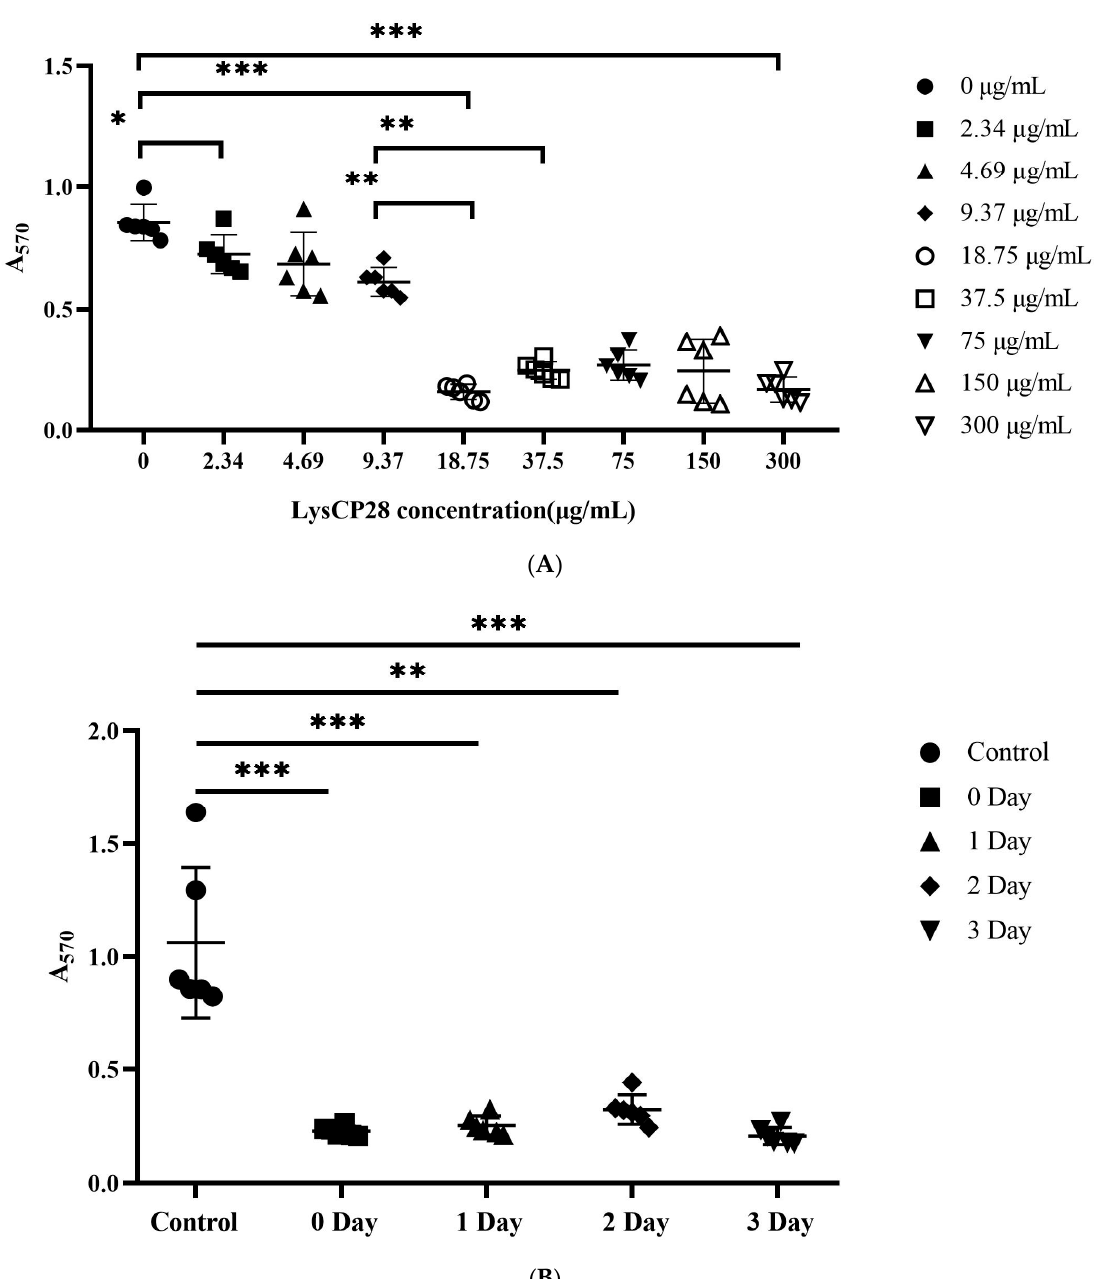
Figure 5. Efficacy of endolysin as antibiofilm agent against C. perfringens J21 strain. ( A ) Preformed biofilms (3-days-old) treated with different concentrations of LysCP28 over 24 h at 37 °C. ( B ) Inhibition in the biofilm formation (1-day-, 2-day, and 3-day-old) using endolysin LysCP28. The bars show the mean A 570 ± SD and 95% confidence interval from six independent experiments. The bars without the letter A were significantly different from the control group. The A 570 comparison between different groups was performed using an independent two-sample t -test. Asterisks represent significant differences between different groups (* p < 0.50, ** p < 0.01, *** p < 0.001). Additionally, LysCP28 (0–300 µ g/mL) was added to biofilms of different maturation times (incubated a 37 °C for 3 days). When LysCP28 was added to biofilms formed by strain J21, A 570 significantly decreased as compared with untreated samples. Thus, the biomass measure in control samples was about 0.91, whereas 1 d-old biofilms treated with endolysin decreased absorbance to 0.24 and 0.29 for those 2 days old, and to 0.21 for 3-